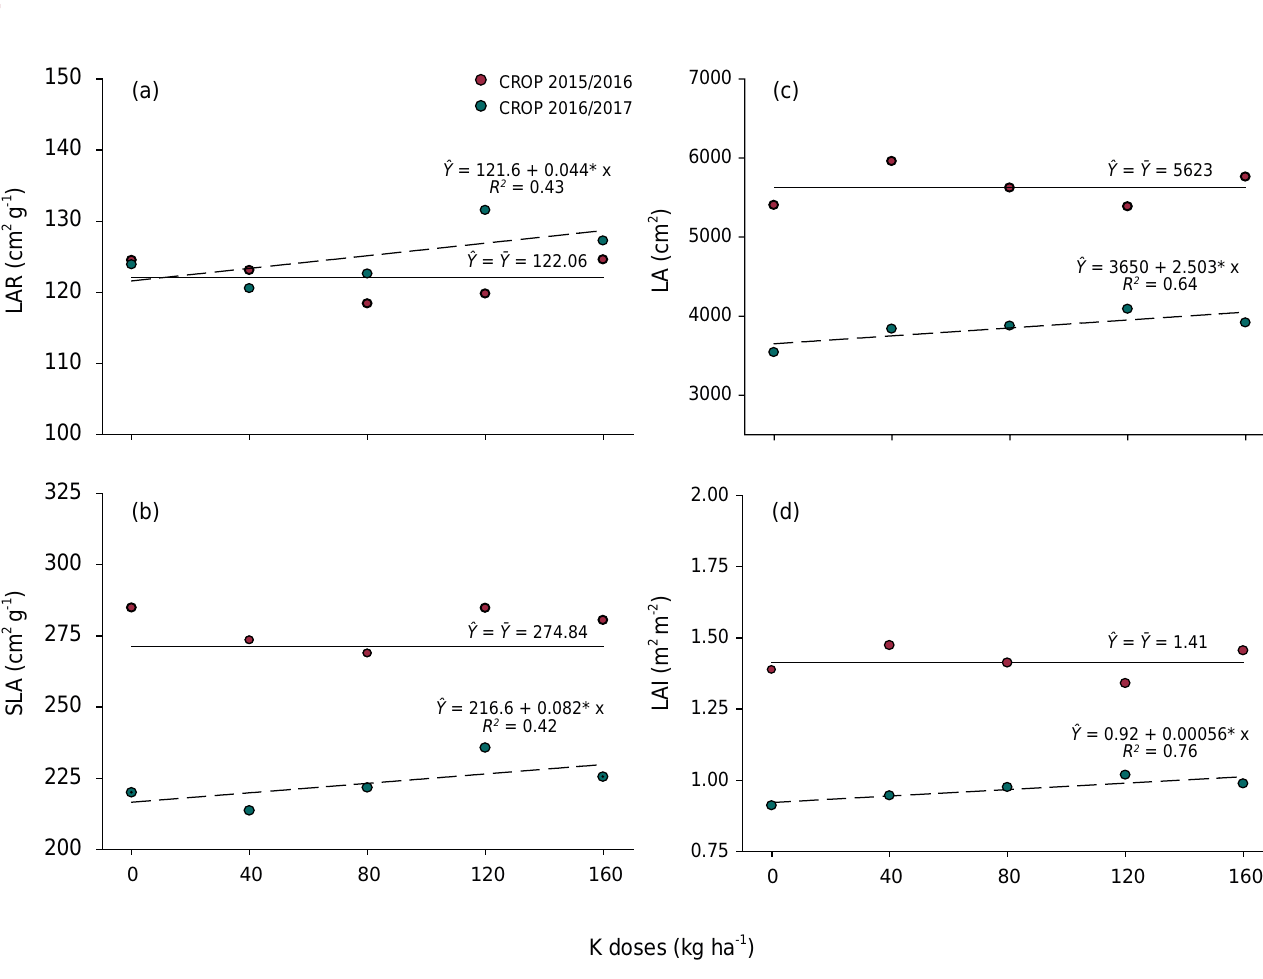
Figure 3. Leaf area ratio (LAR) (a), leaf area (LA) (b), specific leaf area (SLA) (c), and leaf area index (LAI) of soybean for the crops in 2015/2016 and 2016/2017 after the application of different K rates. * = significant at 5